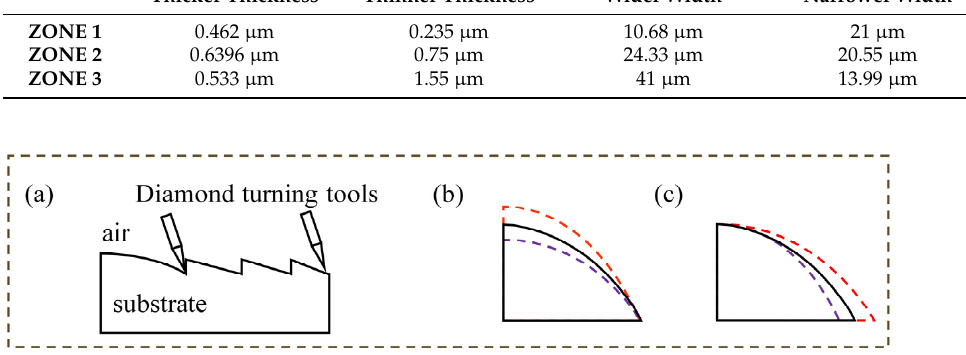
Figure 4. ( a ) Schematic diagram of diamond turning process; ( b ) Possible errors in thickness during processing, with the red dashed line representing a potential higher height change and the purple dashed line representing a potential lower height change; ( c ) Possible errors in thickness during processing, with the red dashed line representing a potential wider height change and the purple dashed line representing a potential narrower height change. Table 3. Data of HMID sensitivity.